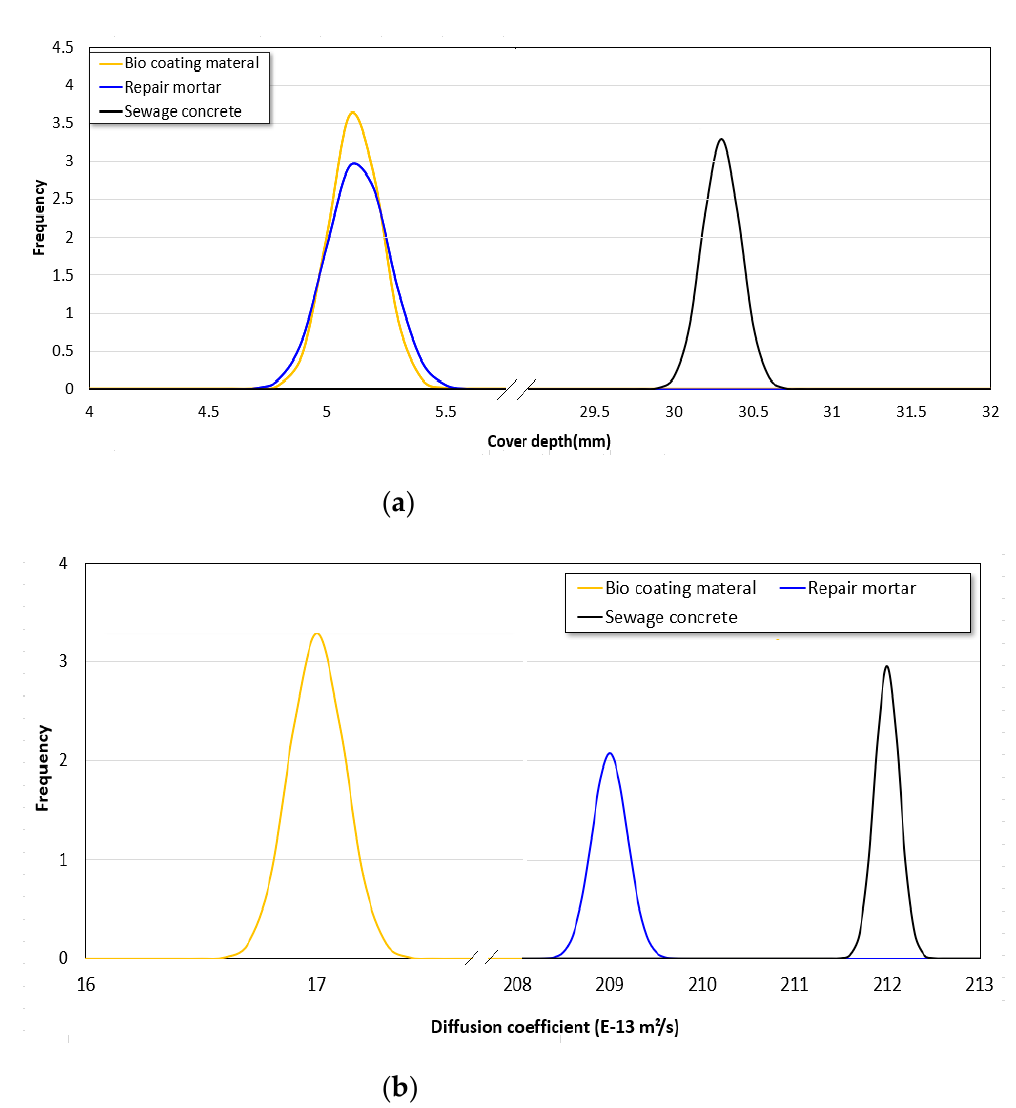
Figure 8. Probability distributions of design: ( a ) probabilistic distribution of thickness; ( b ) probabilistic distributions of diffusion coefficient.